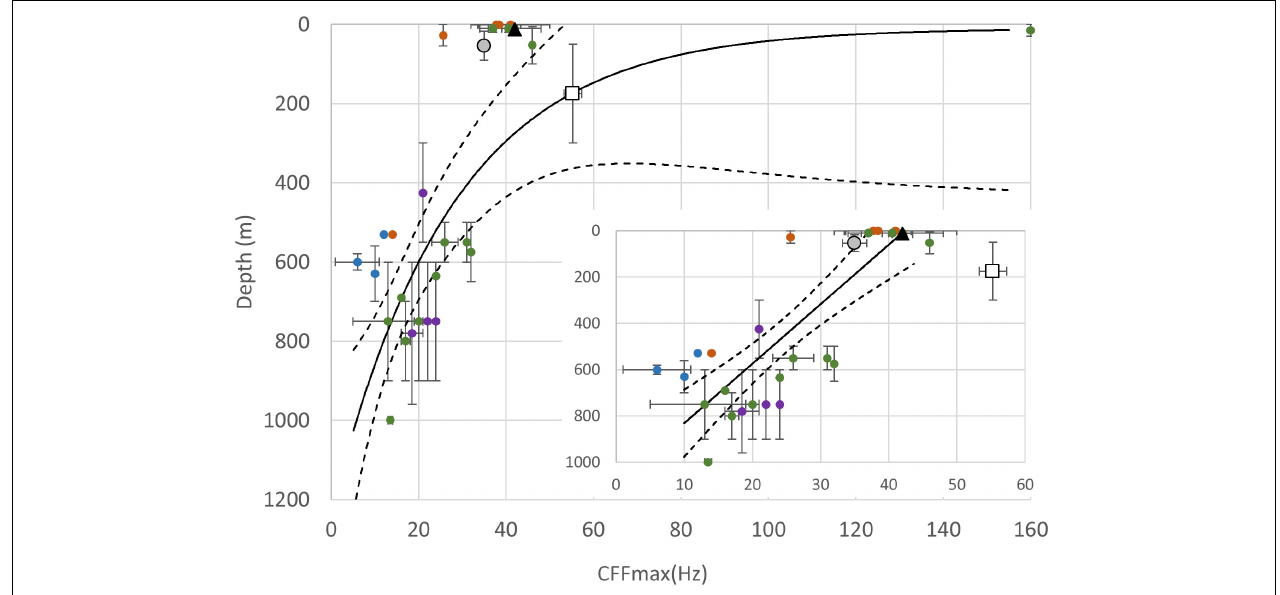
FIGURE 11 | The maximum critical flicker fusion frequencies (CFF max ) and the inhabited depths of slipper lobsters and other decapods. The mean CFF max are shown along the horizontal axis and the error bar indicates the maximum and minimum range for CFF max reported for each species (see Supplementary Data 4 for details). The means of inhabited depth are shown along the vertical axis, and the error bar indicates the range of depths reported in the literature or cited in an online database (https://www.sealifebase.ca/). A one-phase decay exponential regression curve (solid line) or linear regression (small inset figure) was fitted to the plots of the main figure or mini-figure by the least squares method ( R 2 = 0.47 or 0.51, respectively). The 90% confidence level is shown (dashed